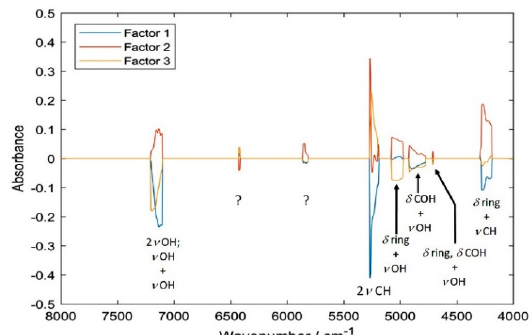
Figure 6. Loadings of the partial least squares regression (PLSR) model correlating NIR spectra of